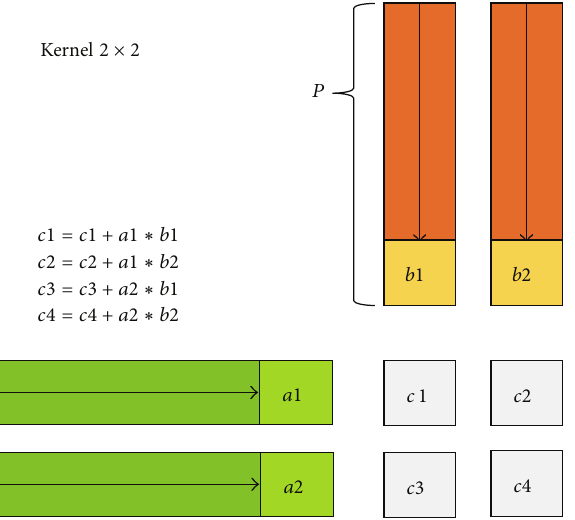
Figure 16: Kernel 2 × 2 composition.